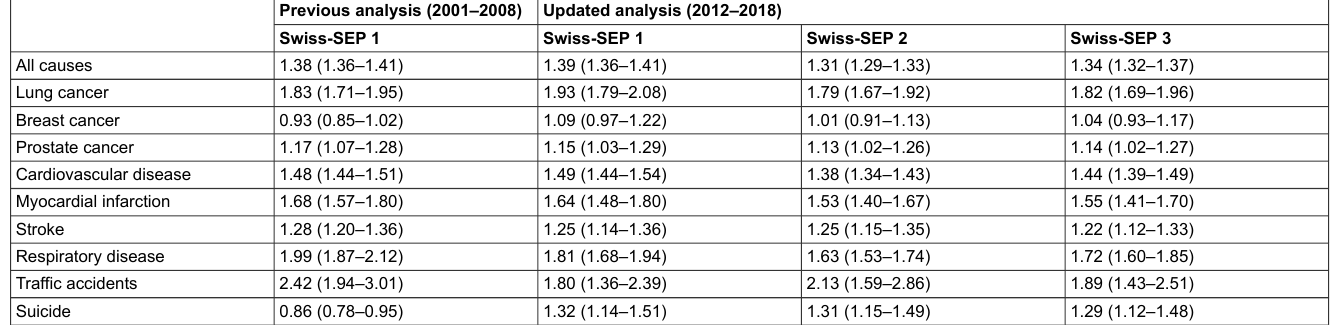
Table 2: Hazard ratios of death from all causes and selected causes in the Swiss resident population comparing the first decile (lowest SEP) of different versions of the Swiss neighbour- hood index of socioeconomic position (Swiss-SEP) to the tenth decile (highest SEP). Source: Swiss National Cohort, 2001–2008 [3] and 2012–2018.